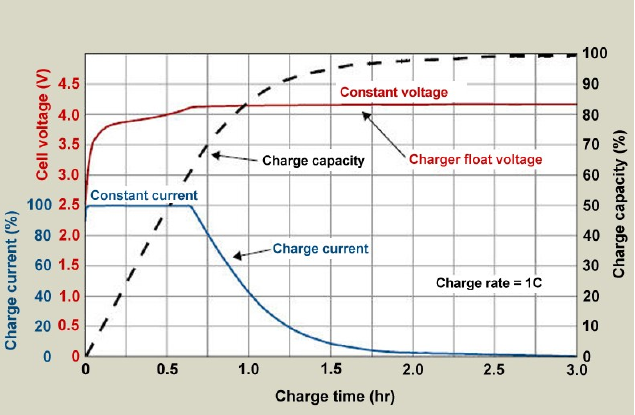
Figure 2. Constant voltage/Constant current charging waveform [40]. Courtesy of CADEX